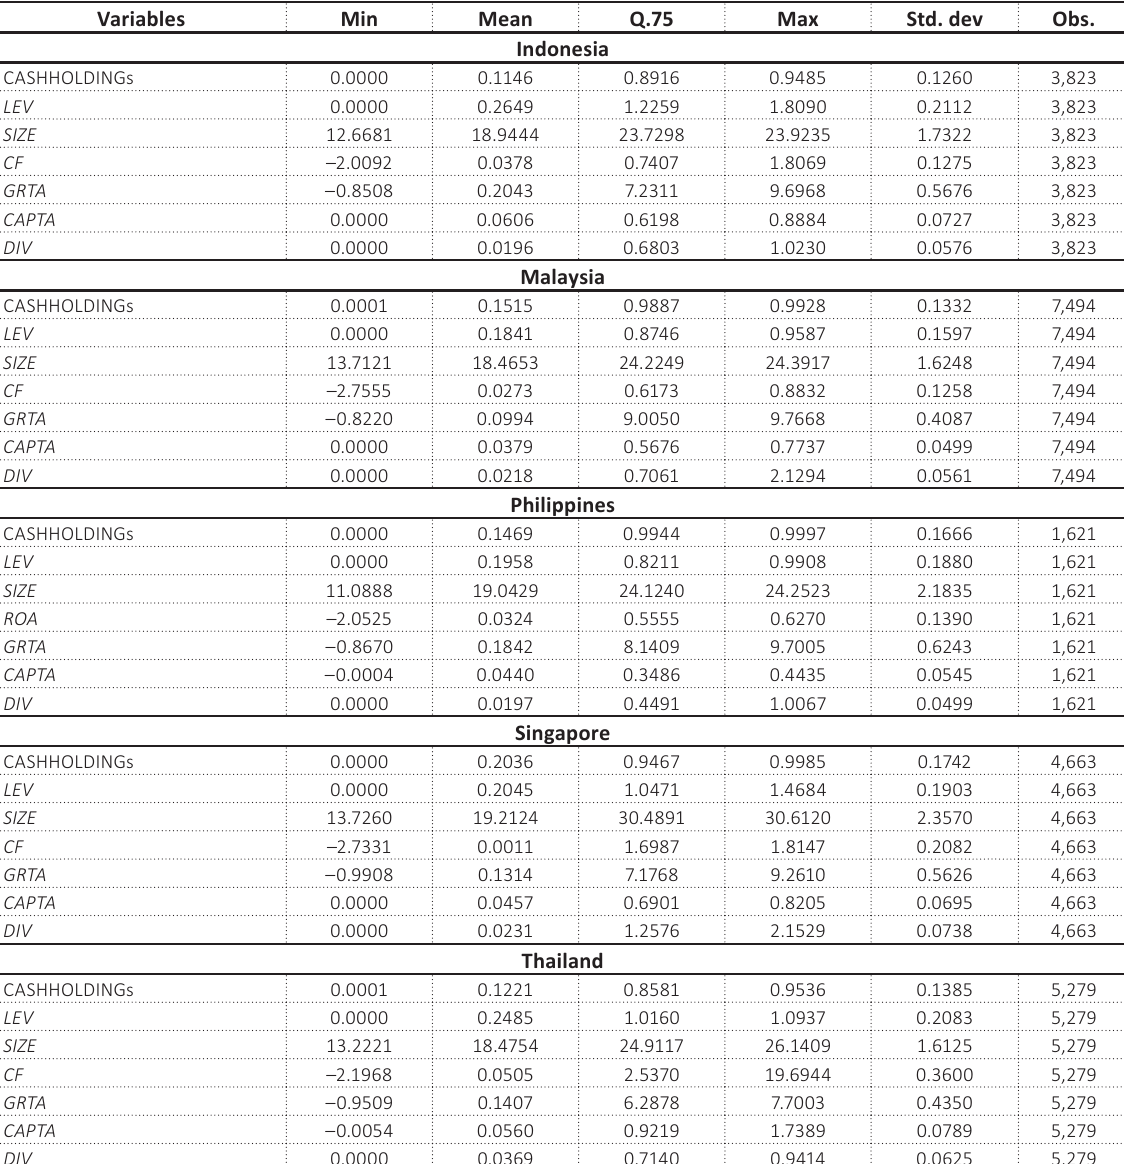
Table 3. Descriptive statistics for firm variables across five countries of the ASEAN region